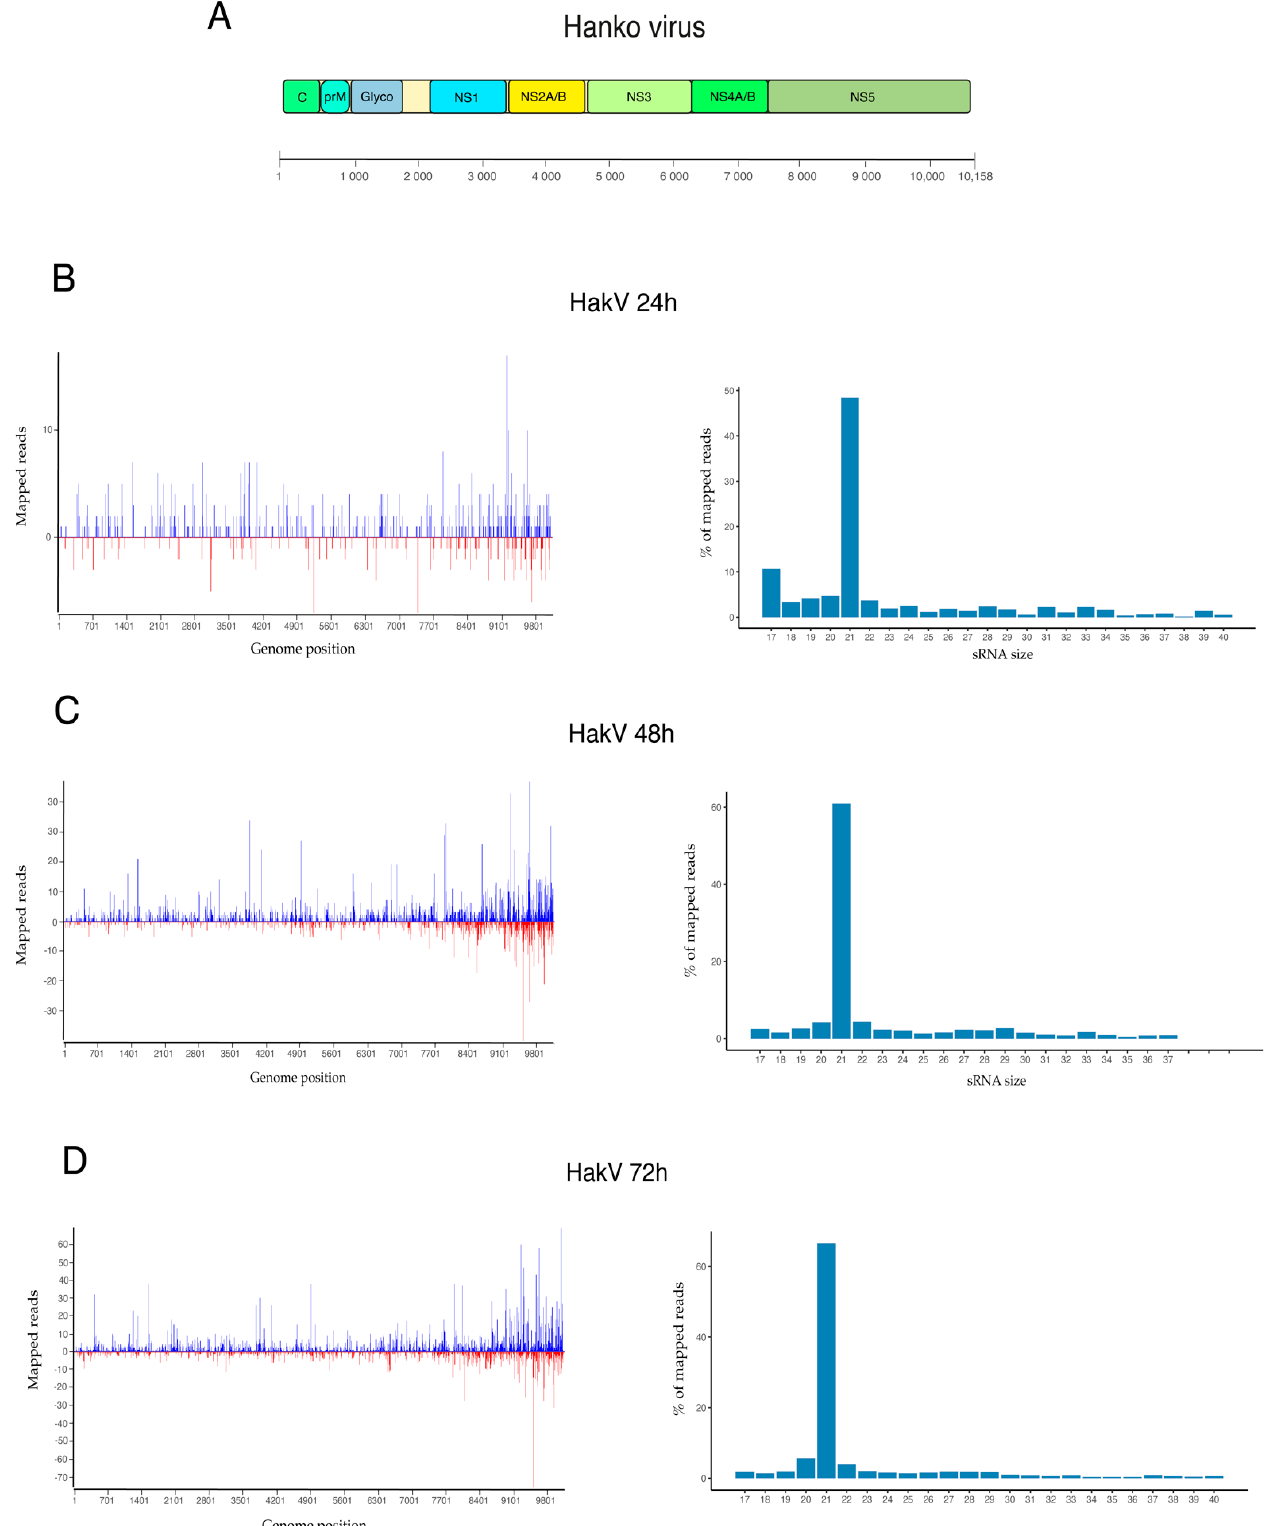
Figure 5. Viral small RNA profiles of U4.4 cells after HakV infection. ( A ) Schematic representation of the HakV genome. vsRNA profiles at 24 h ( B ), 48 h ( C ), and 72 h ( D ) p.i. Figures to the left show vsRNA reads along the HakV genome as a histogram. The positive values are counts of vsRNAs mapped to the sense strand, and the negative values are those mapped to the antisense strand. Figures to the right show the size distribution of reads that mapped to the HakV genome.